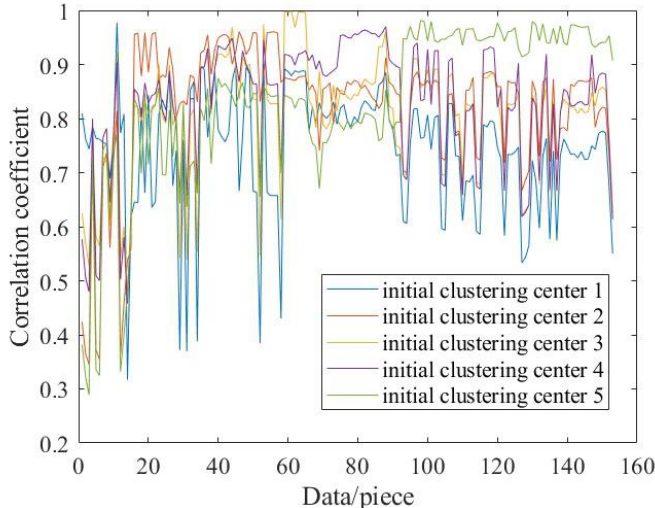
Figure 9. B-phase user voltage correlation coefficient curve.